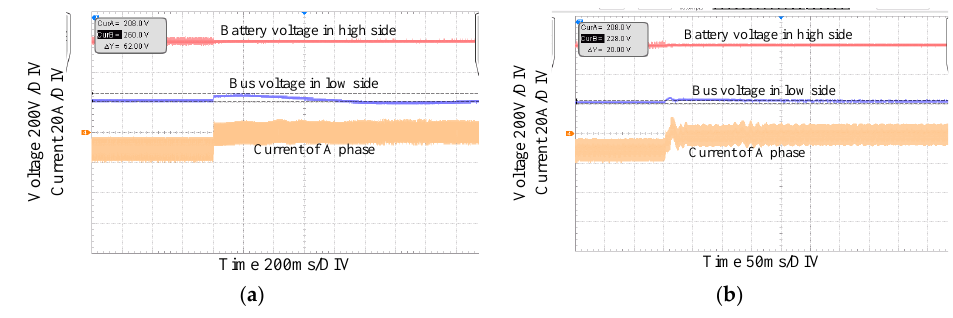
Figure 14. Low bus voltage and A-phase current waveform when 11 kW loads are cut off: ( a ) the bus voltage and A-phase current waveform with the improved feed-forward control; and ( b ) the DC bus voltage and A-phase current waveform without the feed-forward control.